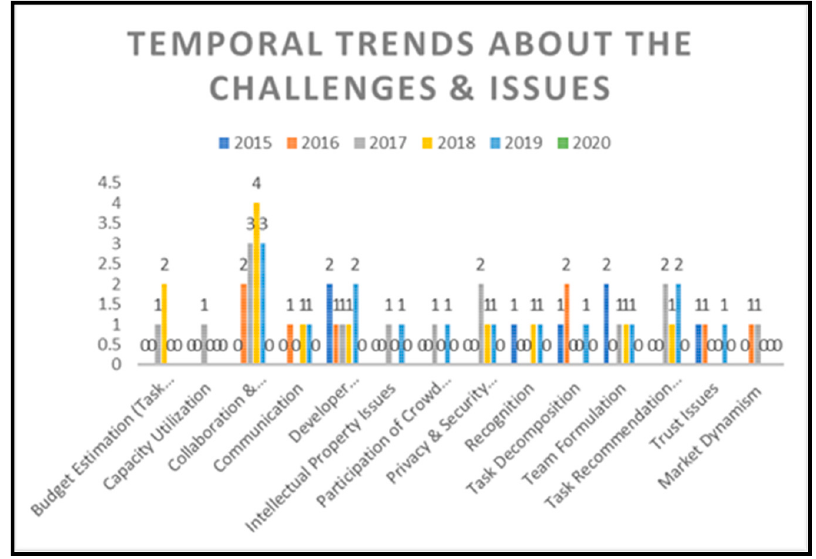
Figure 5. Temporal trends about focused issues and challenges.